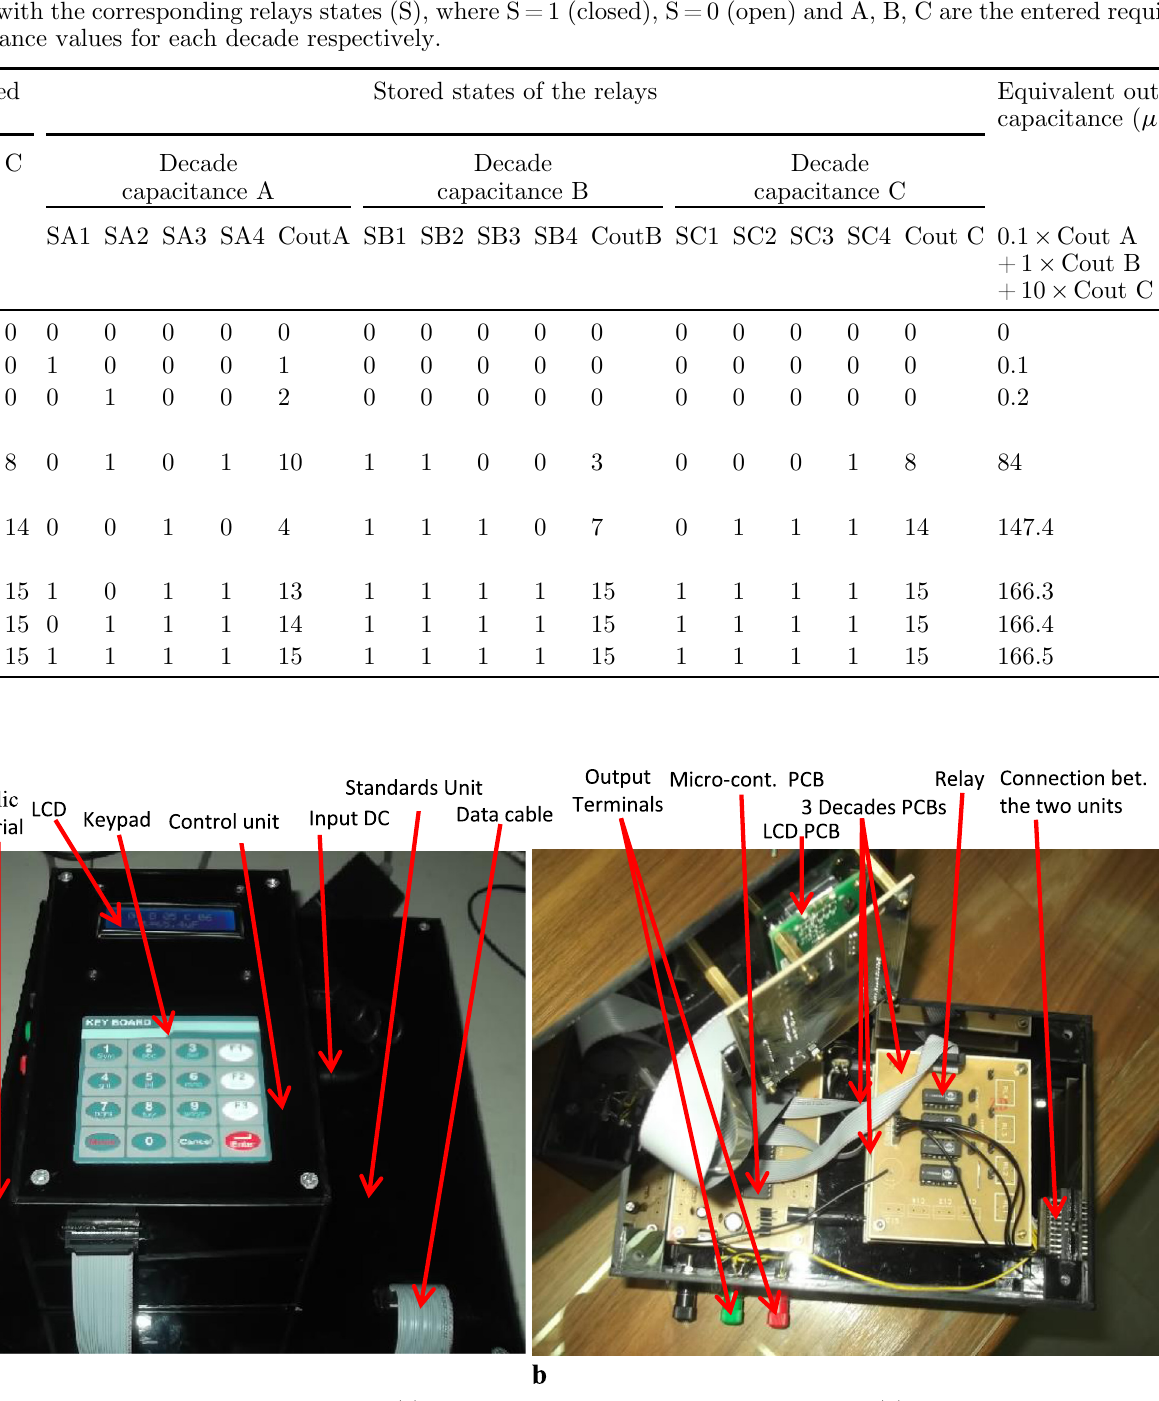
Fig. 2. Recently fabricated capacitance box. (a) Two units of the fabricated capacitance box. (b) Details of the control